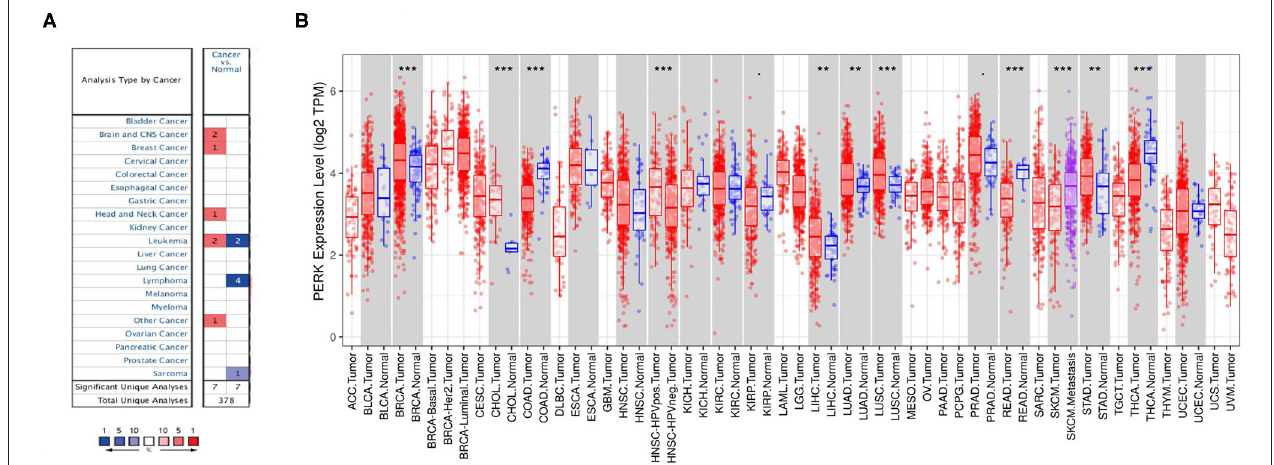
FIGURE 2 | Protein kinase R (PKR)-like endoplasmic reticulum kinase (PERK) expression levels in different types of human cancers. (A) Increased or decreased PERK in data sets of different cancers compared with normal tissues in the Oncomine database. (B) Human PERK expression levels in different tumor types from the TCGA database were determined by TIMER (* p < 0.05, ** p < 0.01, *** p <